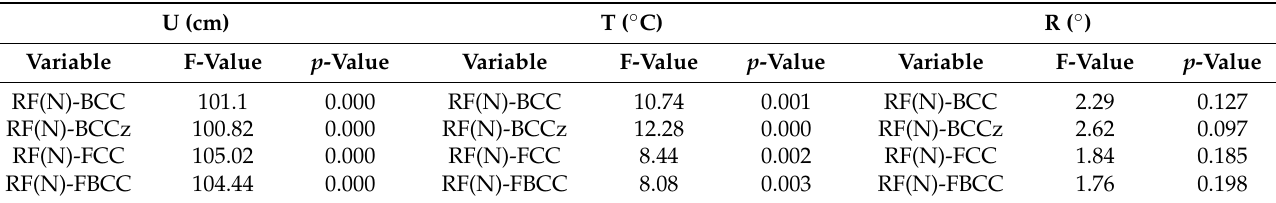
Table 5. ANOVA ( Analysis of variance) of each parameter. Table 5. ANOVA (Analysis of variance) of each